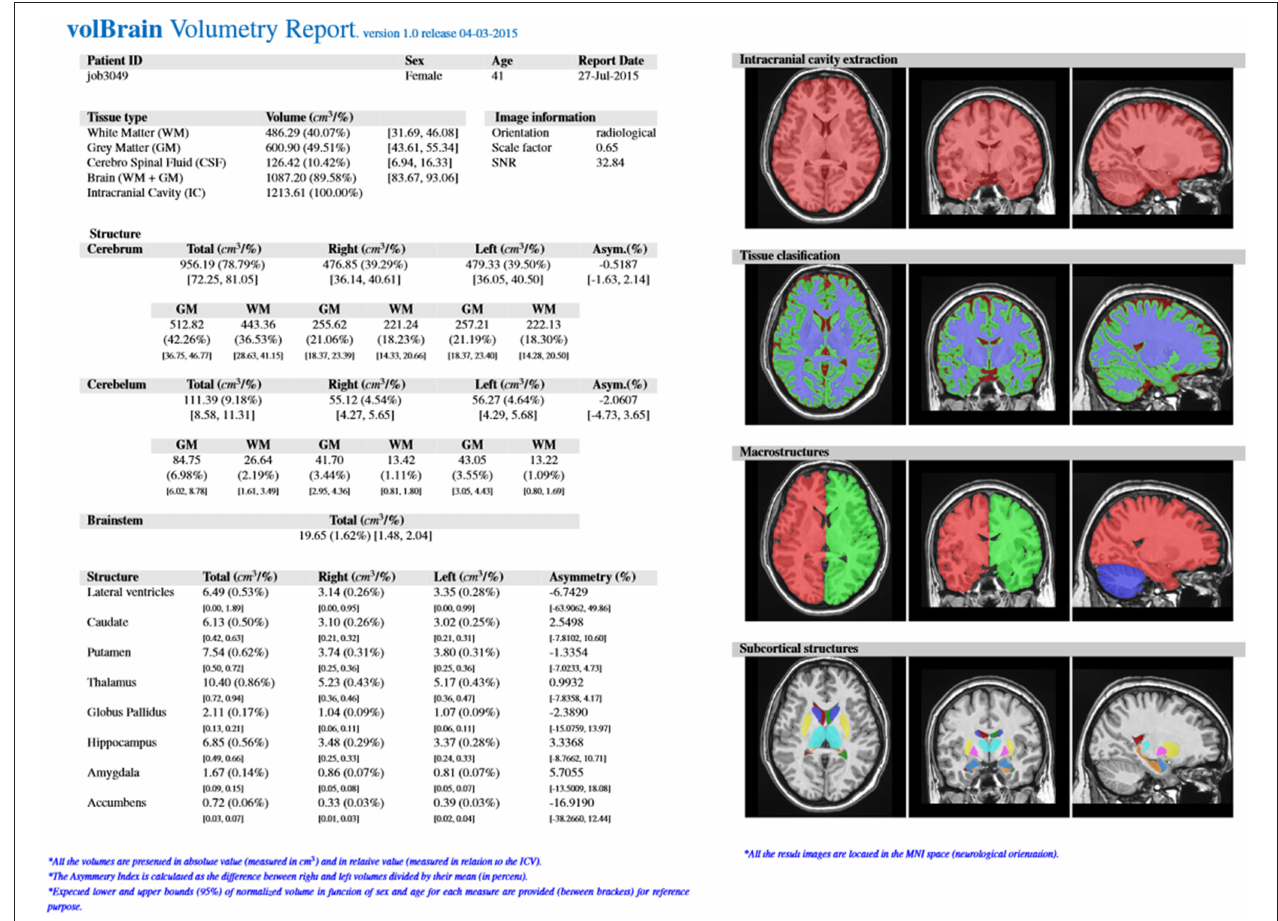
FIGURE 4 | Example of volBrain pdf